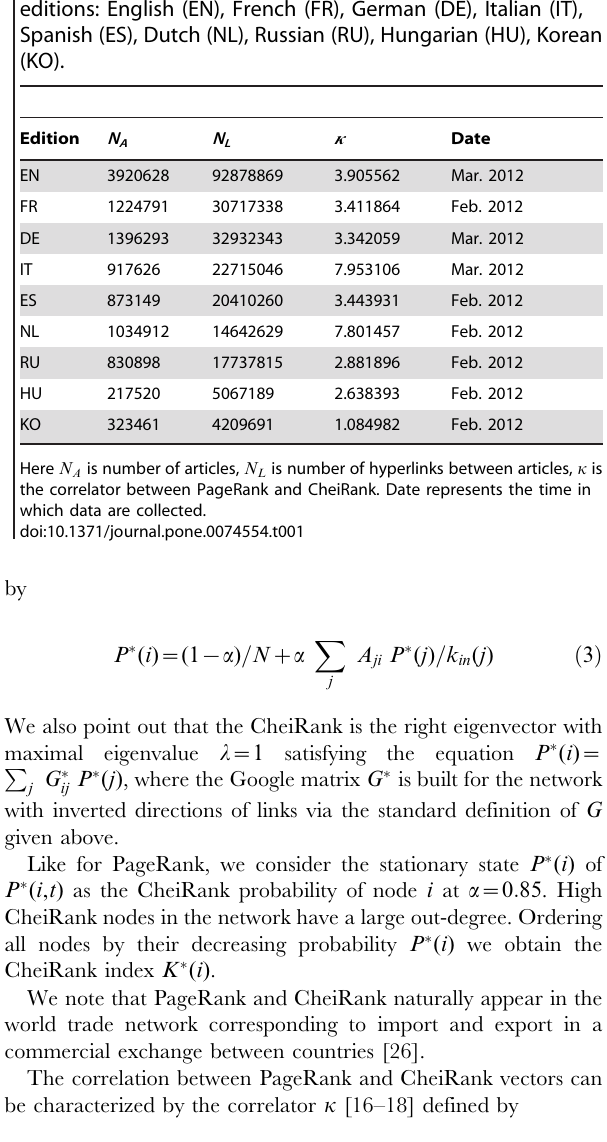
Table 1. Considered Wikipedia networks from